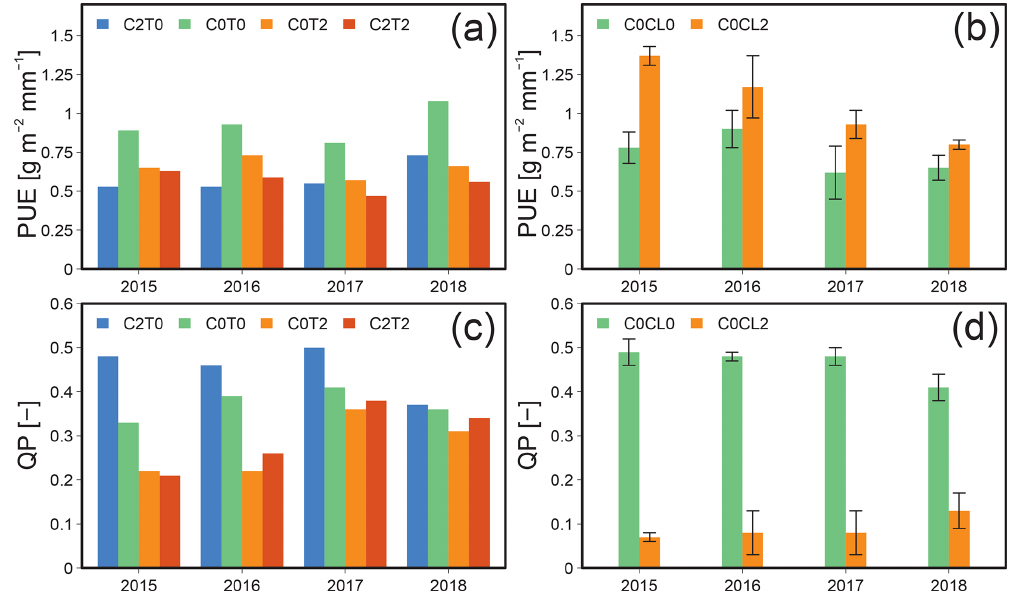
Figure 4. Precipitation use efficiency (PUE) during the observational periods of 2015–2018 for the manipulative approach of Lysi-T-FACE (C2T0, C0T0, C0T2, and C2T2) (a) and observational approach of TERENO-SOILCan (Rollesbroich – C0CL0; Selhausen – C0CL2) (b) , as well as the seepage to precipitation and the NRW ratio QP (–), for the manipulative (c) and observational approach (d) .